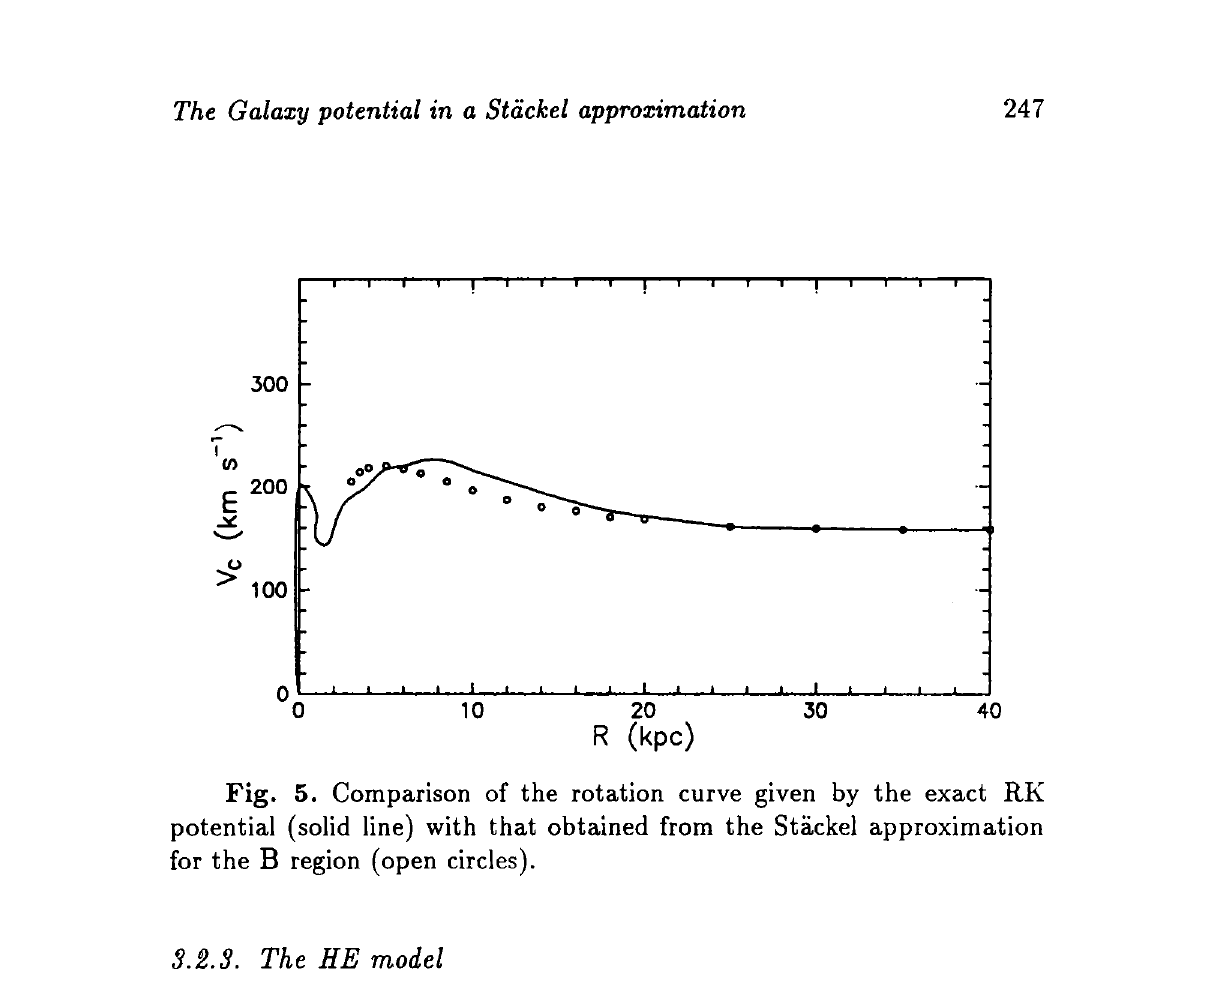
Fig. 5. Comparison of the rotation curve given by the exact RK potential (solid line) with that obtained from the Stackel approximation for the B region (open